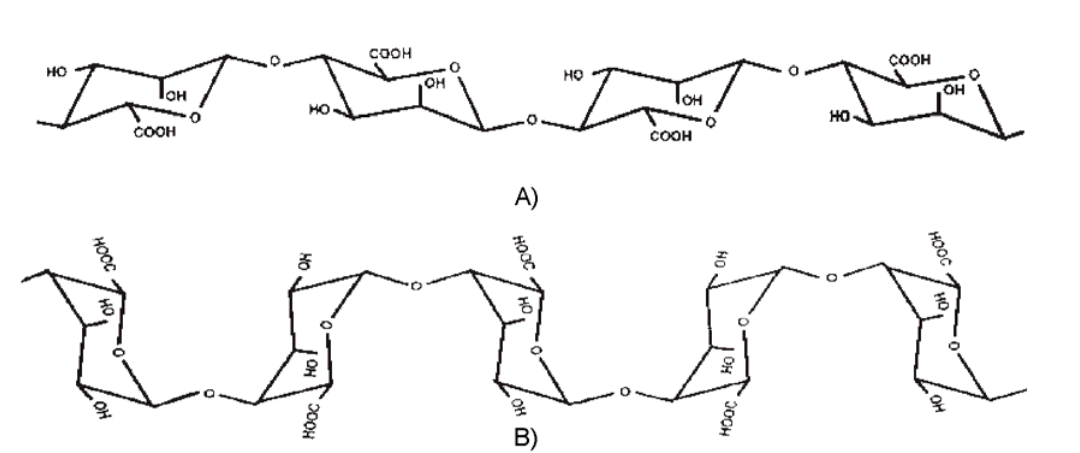
Figure 1. Chemical structure of macromolecules of polymannuronic acid ( A ) and polyguluronic acid ( B ); based on